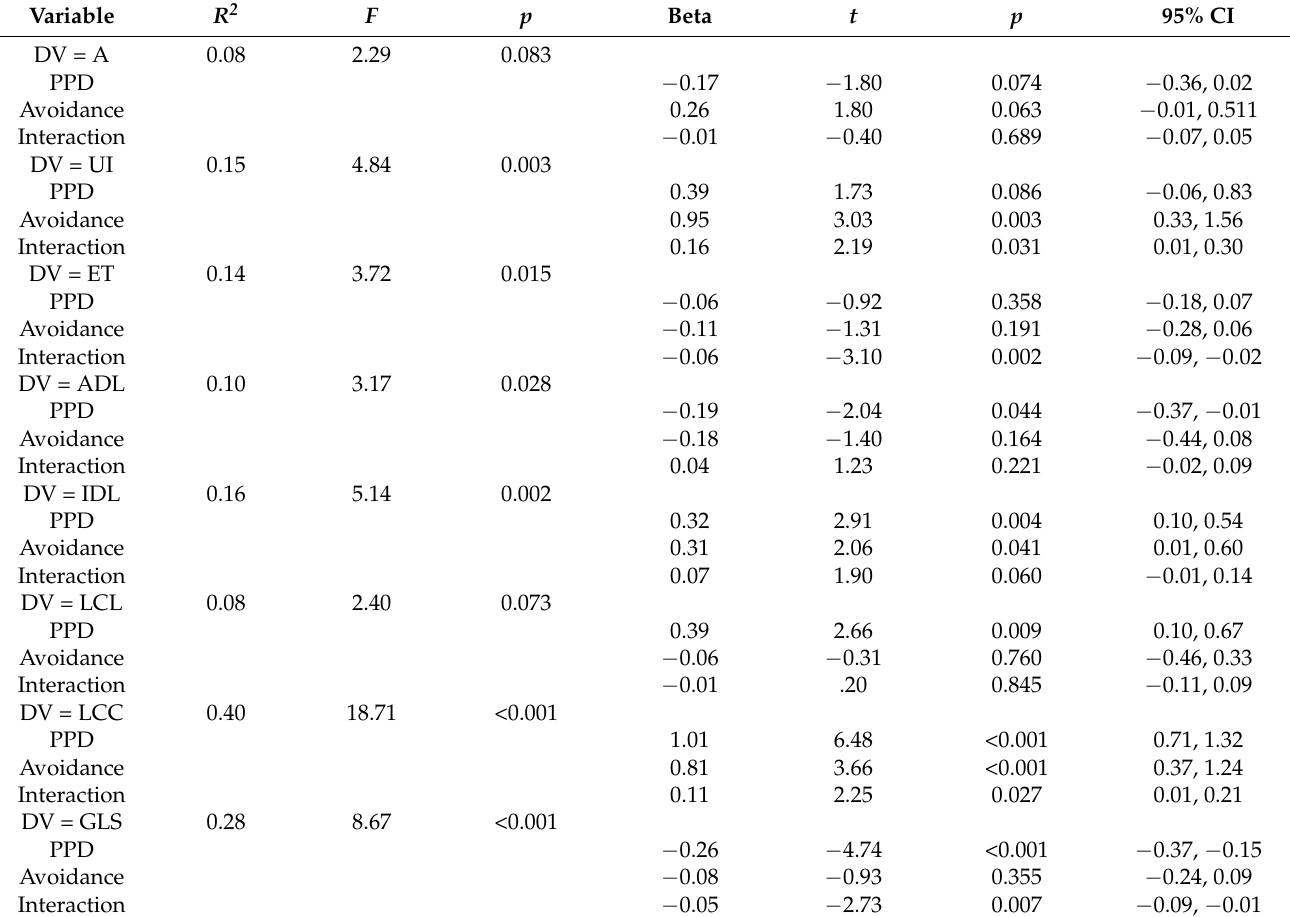
Table 2. Prospective prediction of maternal perceptions about mother–baby relationships from postpartum depression, avoidance coping, and their